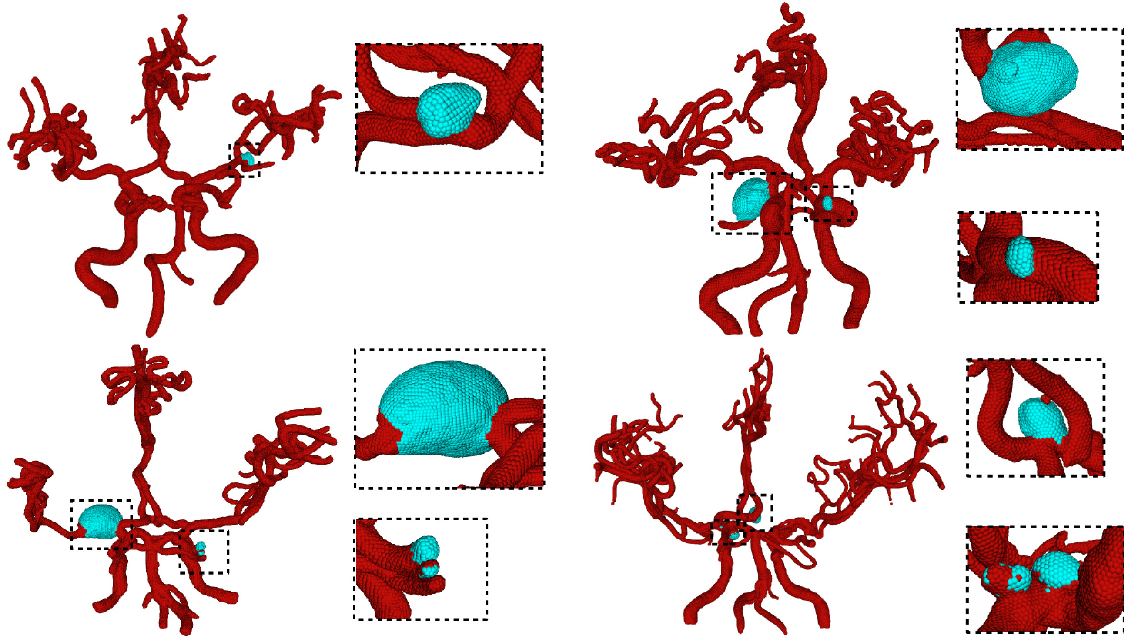
Fig. 8 Examples of final segmentation results (rendered as points); enlarged figures may be captured from a different viewpoint to show the aneurysm shape. Above left: saccular aneurysms. The proposed pipeline obtained a perfect segmentation. Above right: saccular aneurysms. The aneurysm was segmented clearly without the impact of close blood vessels (see top enlargement). A potential aneurysm was also found, which was not annotated by experts (see bottom enlargement). Below left: fusiform aneurysms. The aneurysm was well segmented (see top enlargement). The ends of normal blood vessels were segmented incorrectly into aneurysms (see bottom enlargement). Below right: double saccular aneurysm: multiple aneurysms in one case. Two close aneurysms were annotated as one, and our segmentation did not achieve the same result as Yang et al. [7] as our training data included much more complex shapes.